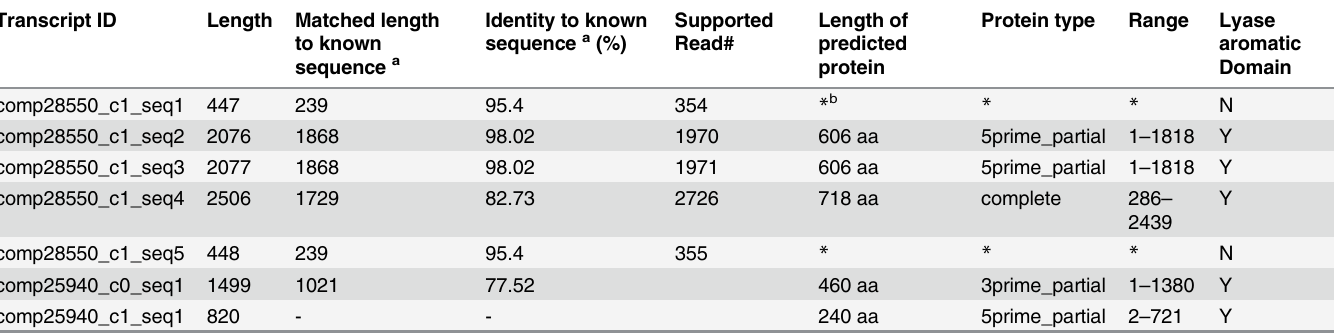
Table 5. Phenylalanine ammonia lyase (PAL) mRNA in de novo assembly transcriptome of C . deserticola